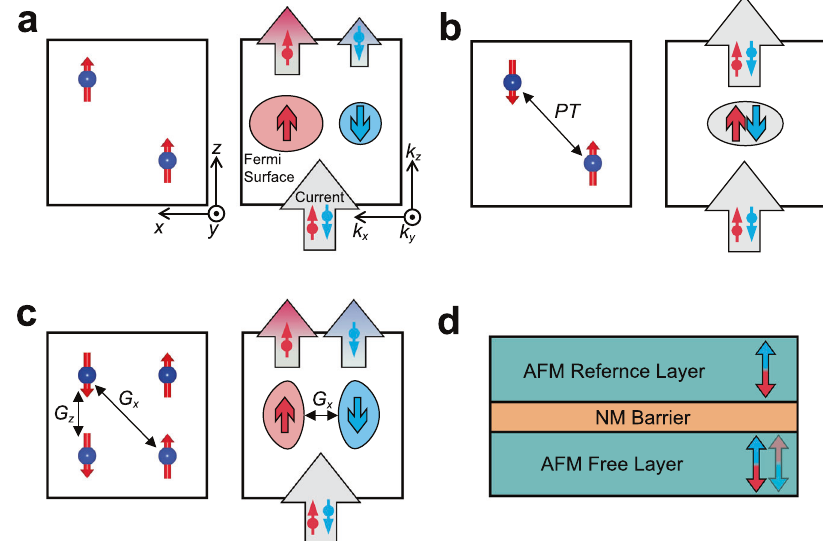
Fig. 1 Spin-polarized conduction channels in different types of magnetic materials. a Schematics of the atomic structure (left) and spin-polarized Fermi surface (right) for a ferromagnet. A spin-neutral current passing through the ferromagnet becomes spin polarized. b Schematics of the atomic structure (left) and spin-degenerate Fermi surface (right) for a compensated antiferromagnet where the net magnetization is forbidden by ^ P ^ T symmetry. A spin- neutral current passing through this antiferromagnet remains spin neutral. c Schematics of the atomic structure (left) and non-spin-degenerate Fermi surface congruent for opposite spins (right) for a compensated antiferromagnet where the net magnetization is forbidden by glide symmetries ^ G x and ^ G z . A spin-neutral current passing through this antiferromagnet remains globally spin neutral but has a momentum-dependent spin polarization. d Schematics of an AFMTJ where two antiferromagnetic (AFM) layers are separated by a nonmagnetic (NM) barrier layer. The Néel vector (indicated by arrows) of the bottom free layer can be switched resulting in the TMR